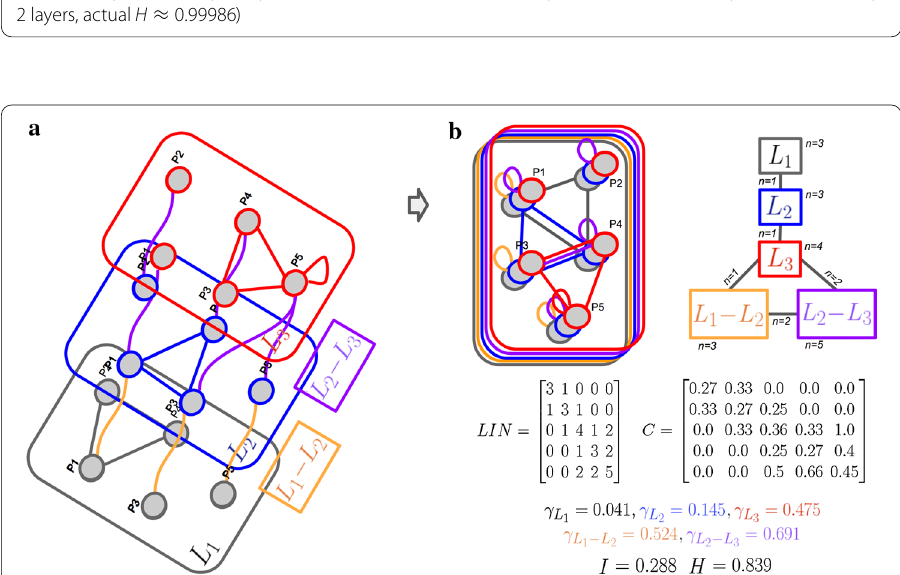
Fig. 4 Computing entanglement on both inner-layer and coupling edges. a Note that in contrast to the example in Fig. 3, we have added a loop to node p 5 in layer L 3 (in red) and a coupling edge connecting nodes p 3 of layer L 2 to p 5 in L 3 . b Computing the corresponding LIN and entanglement measures. We can notice that the most intertwined transition coupling displays the highest entanglement index. Because there is limited overlap between elementary layer edges and transition coupling edges, entanglement intensity I is rather